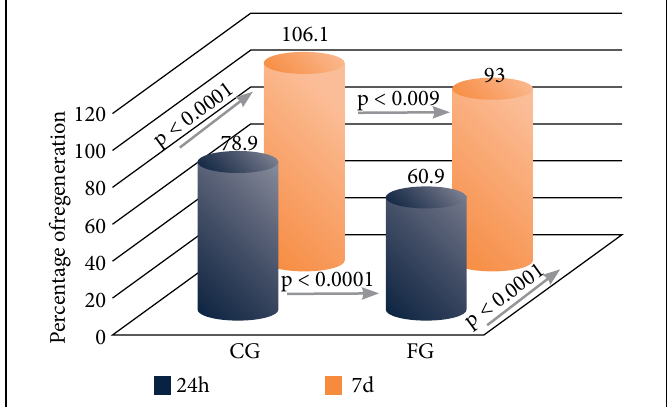
Figure 2 - Liver regeneration percentages by Kwon formula. Statistical comparisons between the control (CG) and 5-fluorouracil (FG) groups at 24 h and 7 days. Blue: 24-h subgroups; Red: 7-day subgroups. p: Student’s t test.